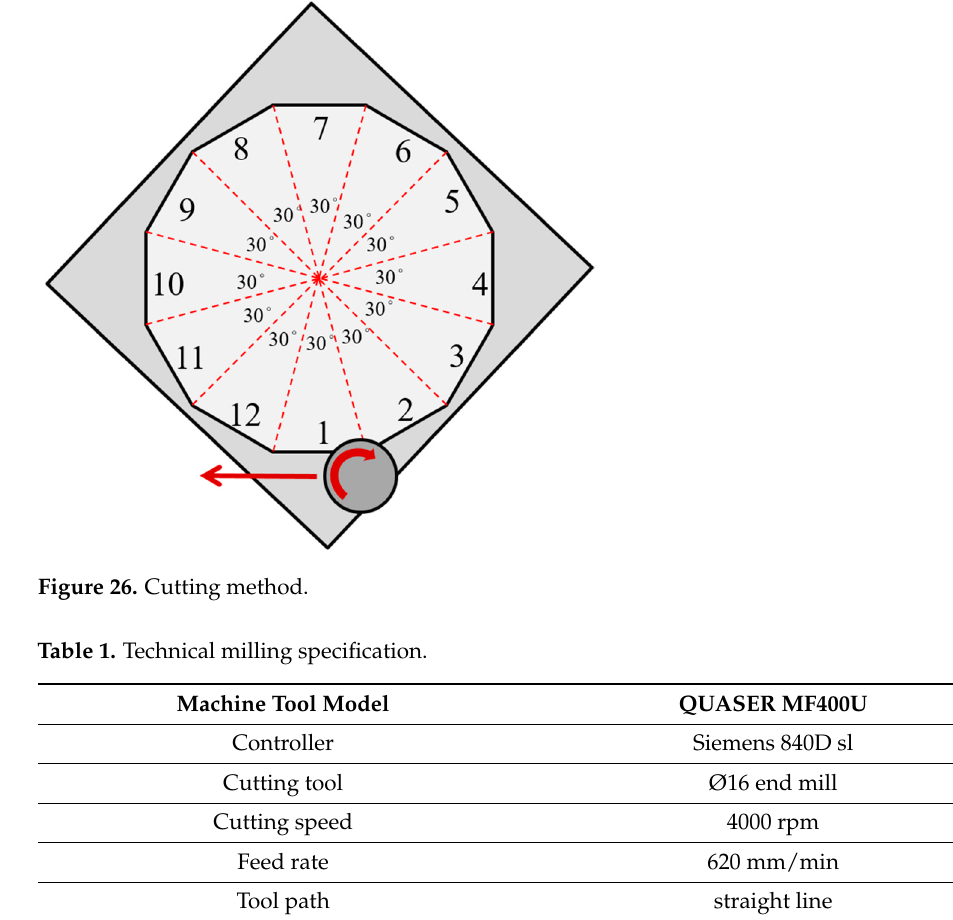
Figure 25. Experimental process.